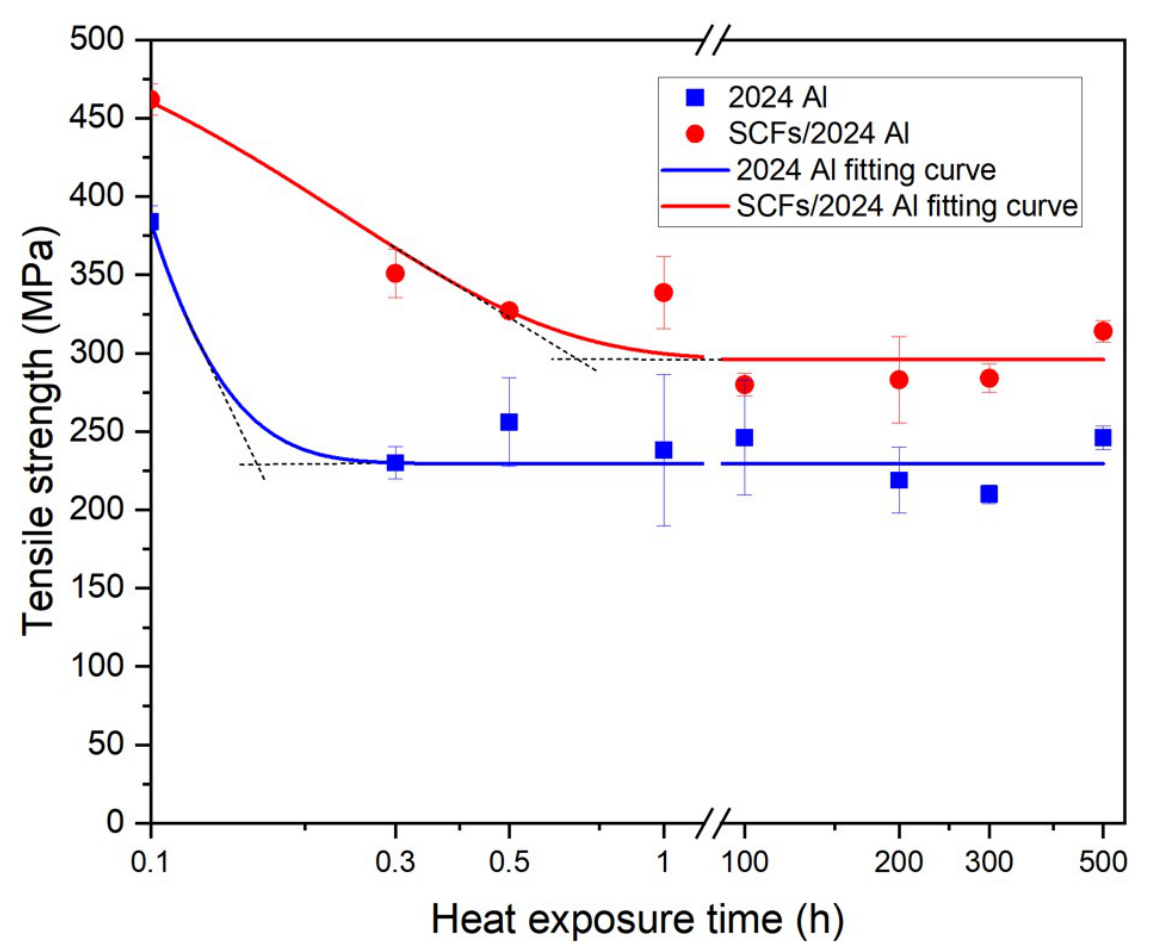
Figure 7. Tensile strength for 2024 Al and SCFs/2024 Al with the change of thermal exposure time. (Samples without thermal exposure are defined as 0.1 h).